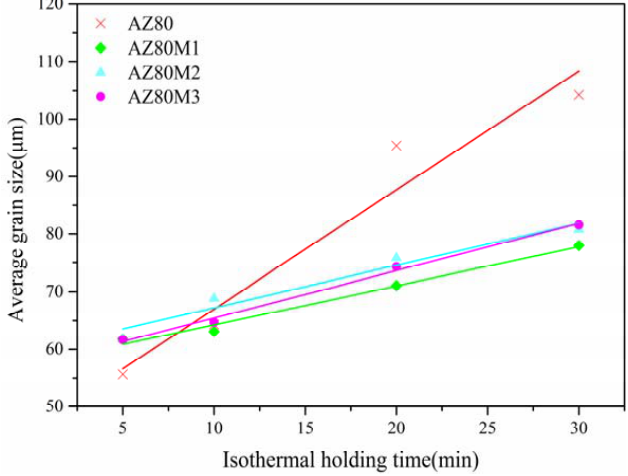
Figure 9. Effect of Y addition on the average solid grain size at 570 °C for different isothermal holding times.